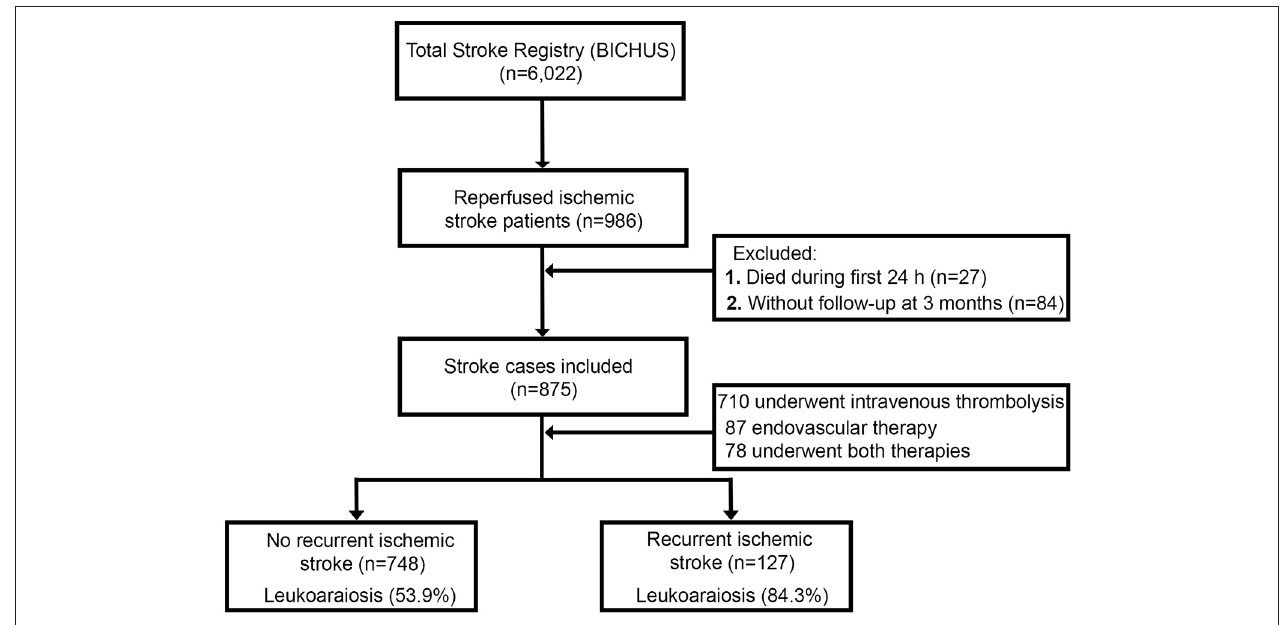
FIGURE 1 | Flowchart of patient groups and